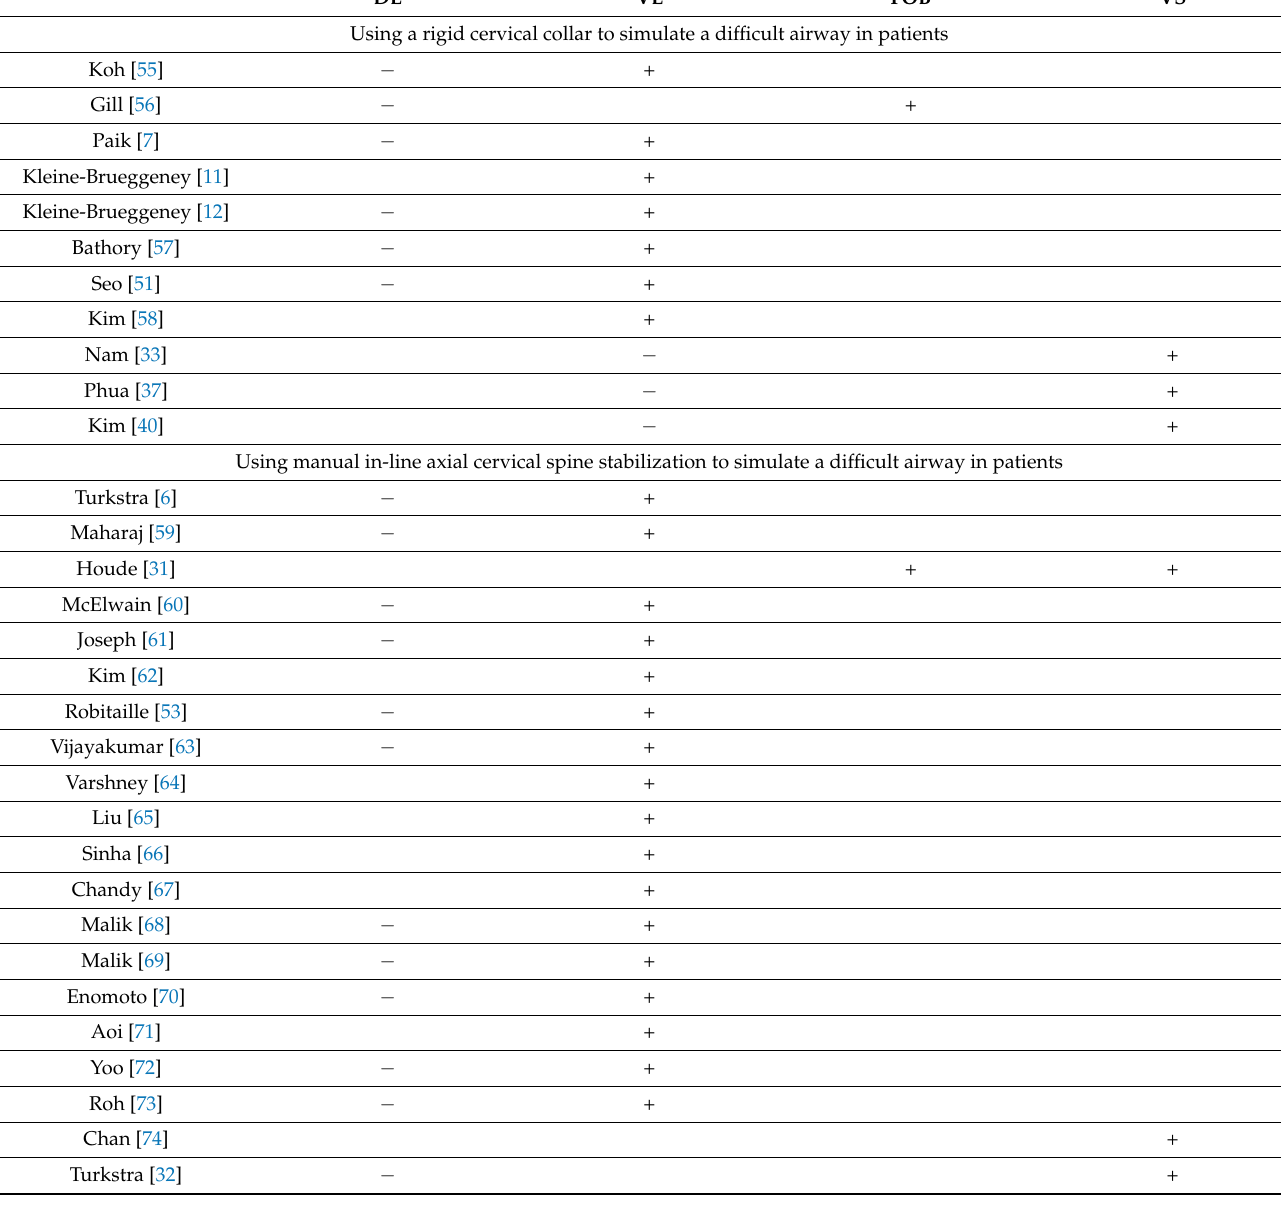
Table 1. Comparison among various airway tools in restricted C-spine scenarios. DL VL FOB